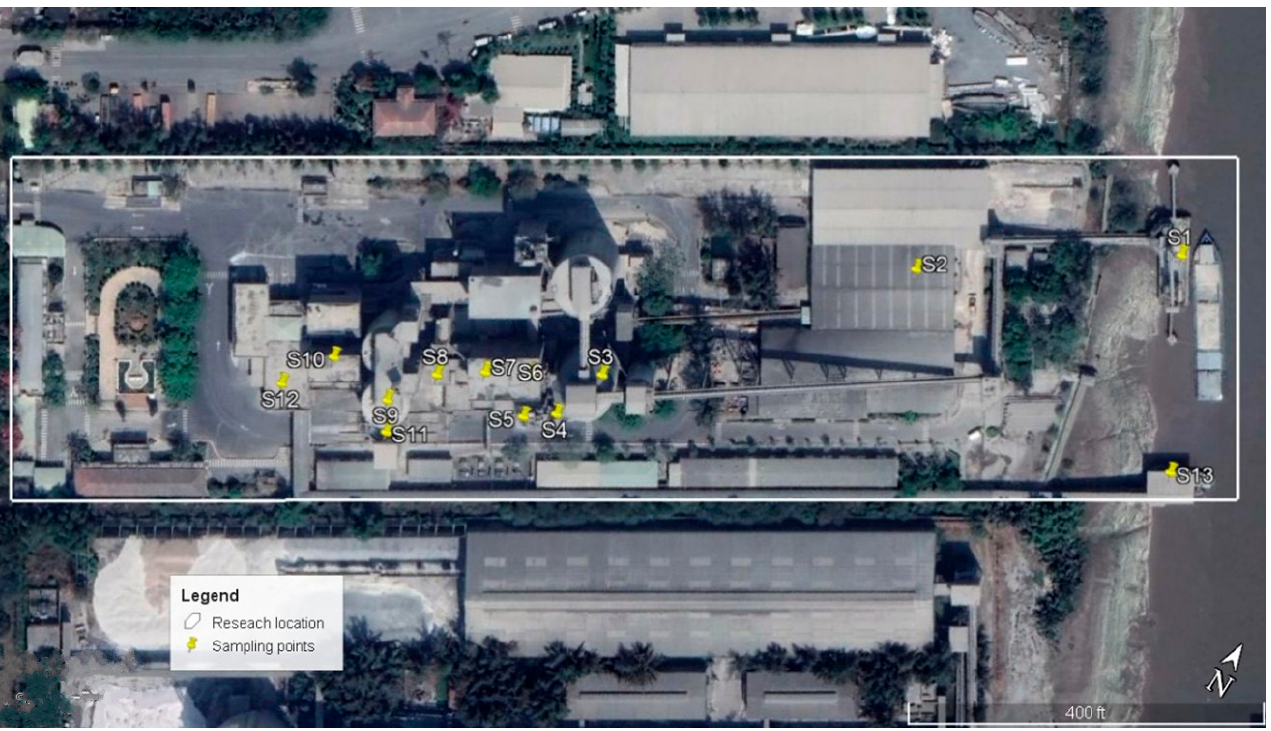
Figure 1. The layout of dust sampling.